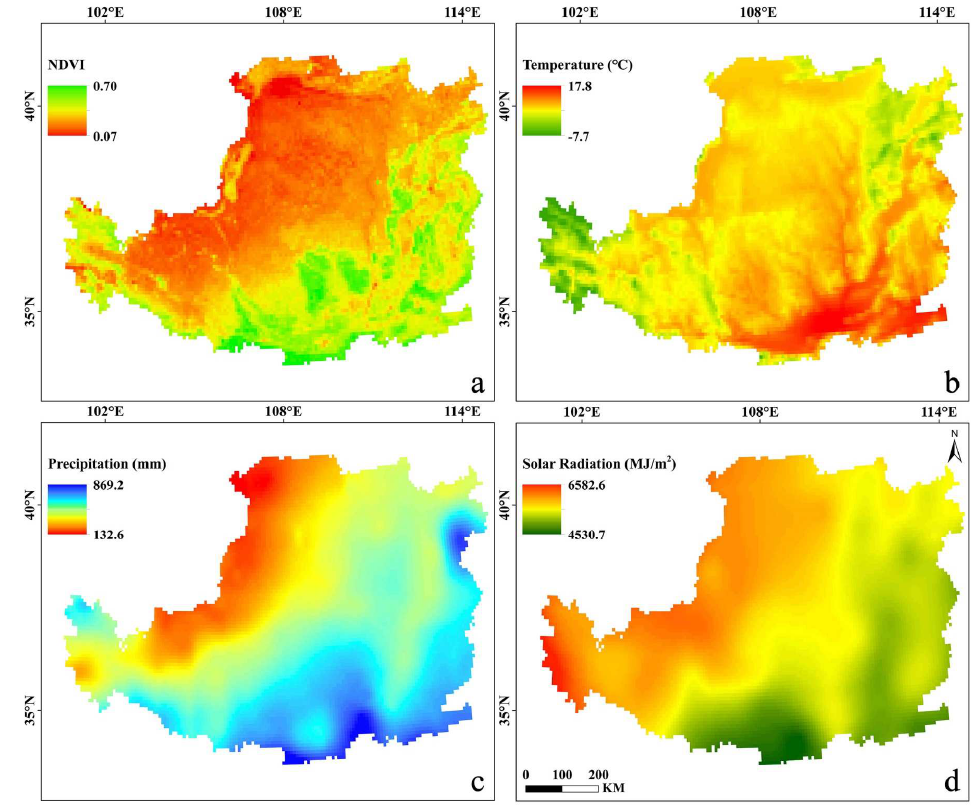
Figure 7. Spatial patterns of 34 years of mean ( a ) NDVI, ( b ) temperature, ( c ) precipitation, and ( d ) solar radiation in the LP.